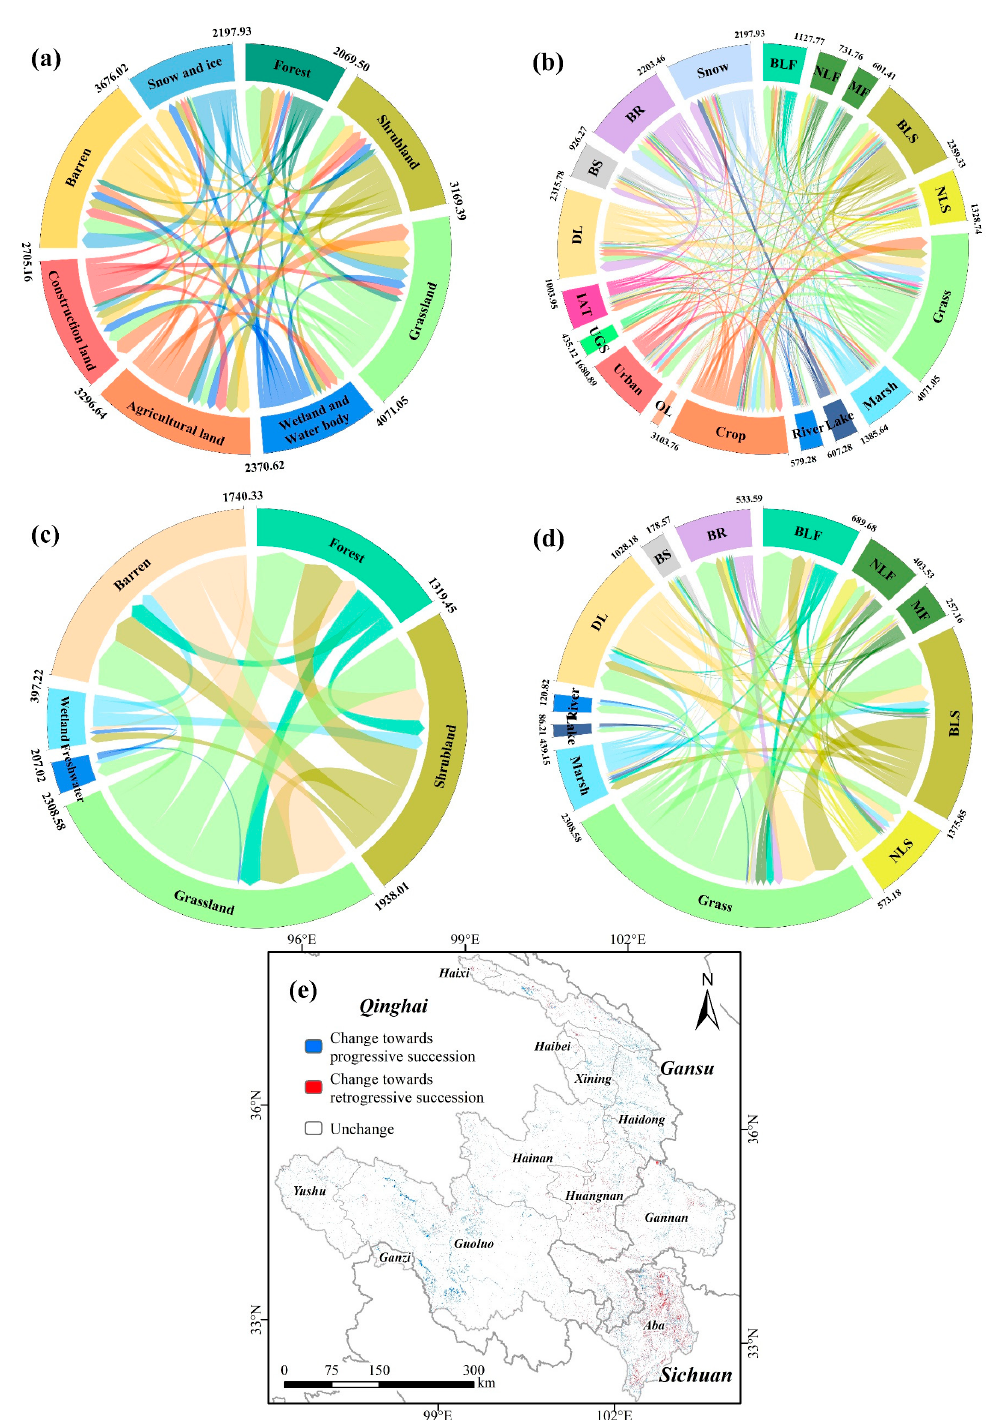
Figure 10. 2018–2020 LULC transition matrix and changes in ecosystem types; the width of the chord represents the area of the transfer. ( a ) First-degree class transition matrix chord diagram; ( b ) second-degree class transition matrix chord diagram; ( c ) first-degree class chord diagram of changes in ecosystem types; ( d ) second-degree class chord diagram of changes in ecosystem types; ( e ) distribution of changes in ecosystem types based on ecological succession and LULC.